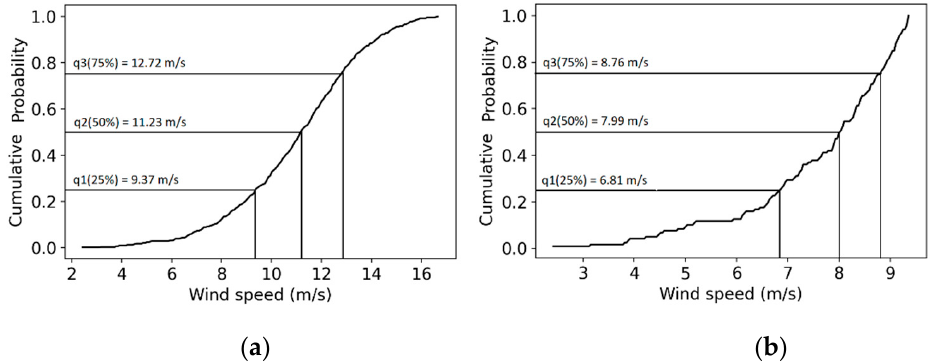
Figure 5. ( a ) Cumulative distribution function of the wind speed for the period 1980–2019; ( b ) second Cumulative distribution function of the wind speed using the wind speed below the q1.